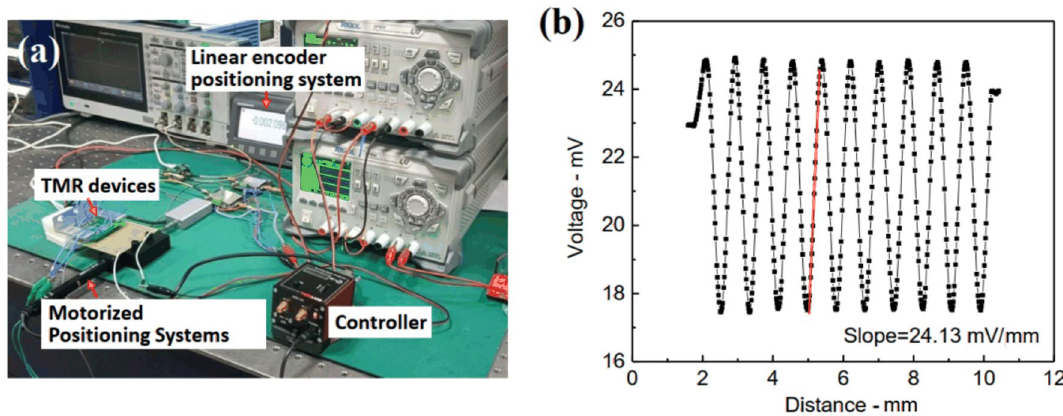
Figure 7. Experimental tests of the TMR devices. ( a ) Experimental setup. ( b ) The magnetic-resistance sensitivity of the TMR